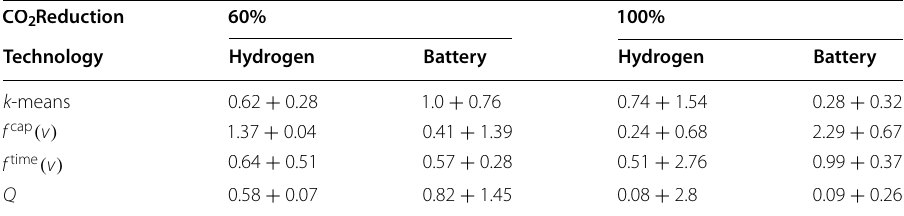
Table 8 Mean squared error presented as a sum of over- and underestimated optimal estimates MSE MSE ( MSE + + − ) according to equation (14) respective clustering method, storage technology = and carbon reduction target for a spatial resolution of 97 nodes. Graphically presented in Fig. 10